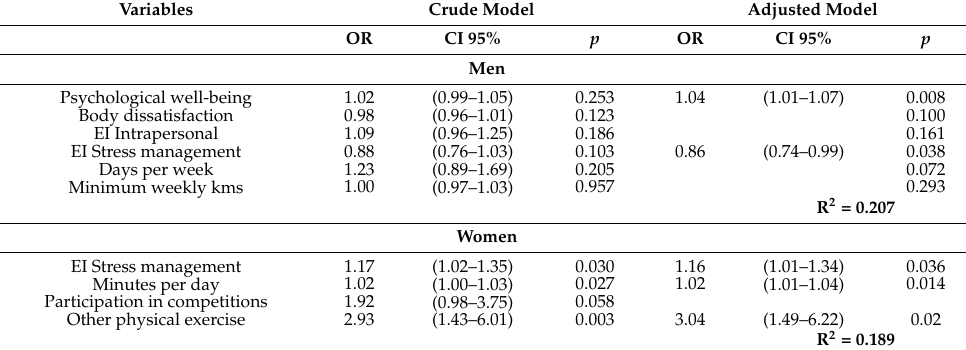
Table 4. Multivariate model for the detection of predictor variables for running in natural areas, by